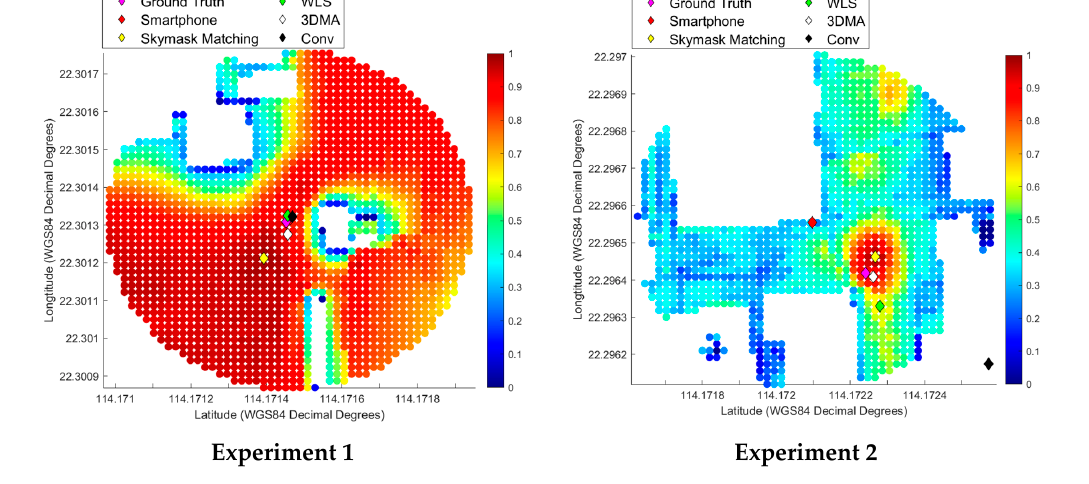
11 of 16 Table 3. Segmented skymask accuracy. Comparison to: